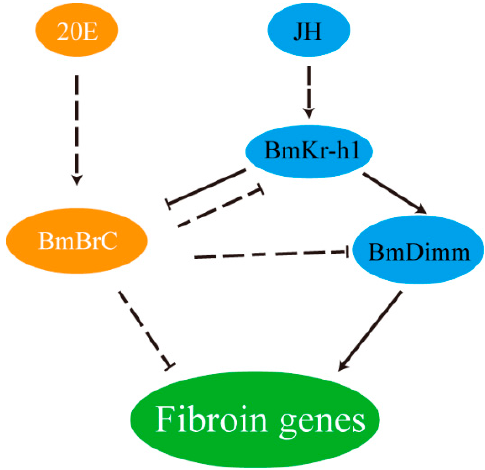
Figure 5. Schematic representation of the hypothesis for molecular regulatory mechanism of BmBrC inhibiting the expression of silk protein genes. At the molting stage, 20-hydroxyecdysone (20E) activates the expression of BmBrC . BmBrC-Z2 inhibits the expression of fibroin genes directly by binding to the upstream regulatory elements or indirectly by BmKr-h1 and BmDimm in the JH signal pathway. At the inter-molting stage, JH activates the expression of BmKr-h1 . BmKr-h1 inhibits the expression of BmBrC-Z2 and meanwhile activates the expression of BmDimm , then activates the transcription of fibroin genes in the silkworm .